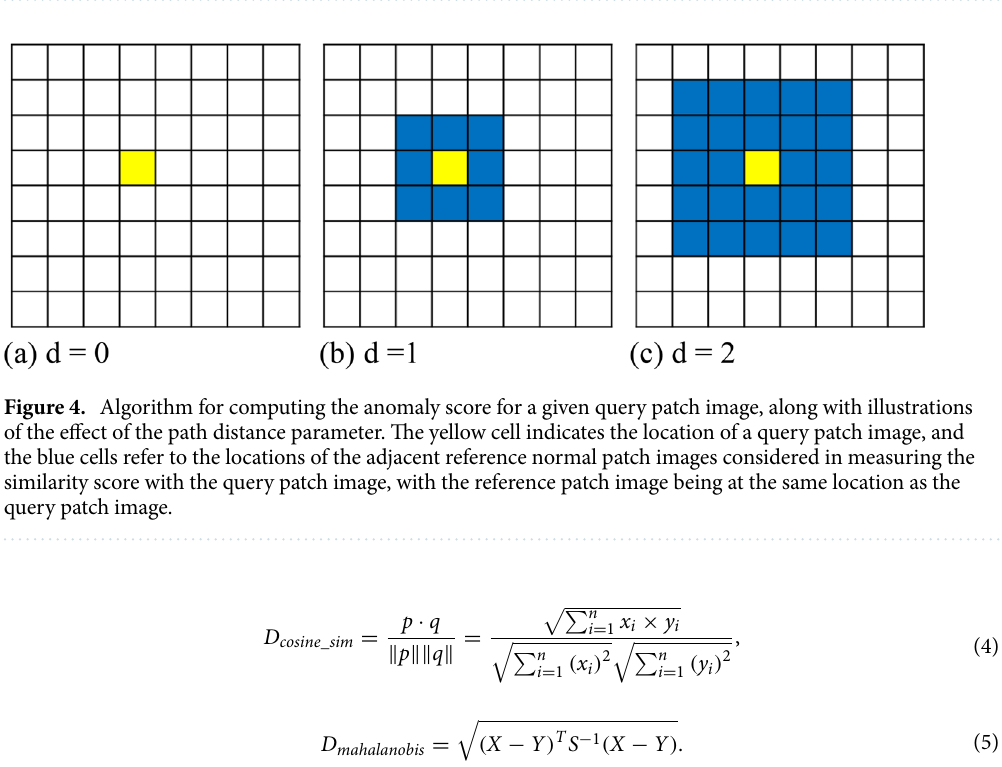
Figure 3. Algorithm for computing the anomaly score for a given query patch image.